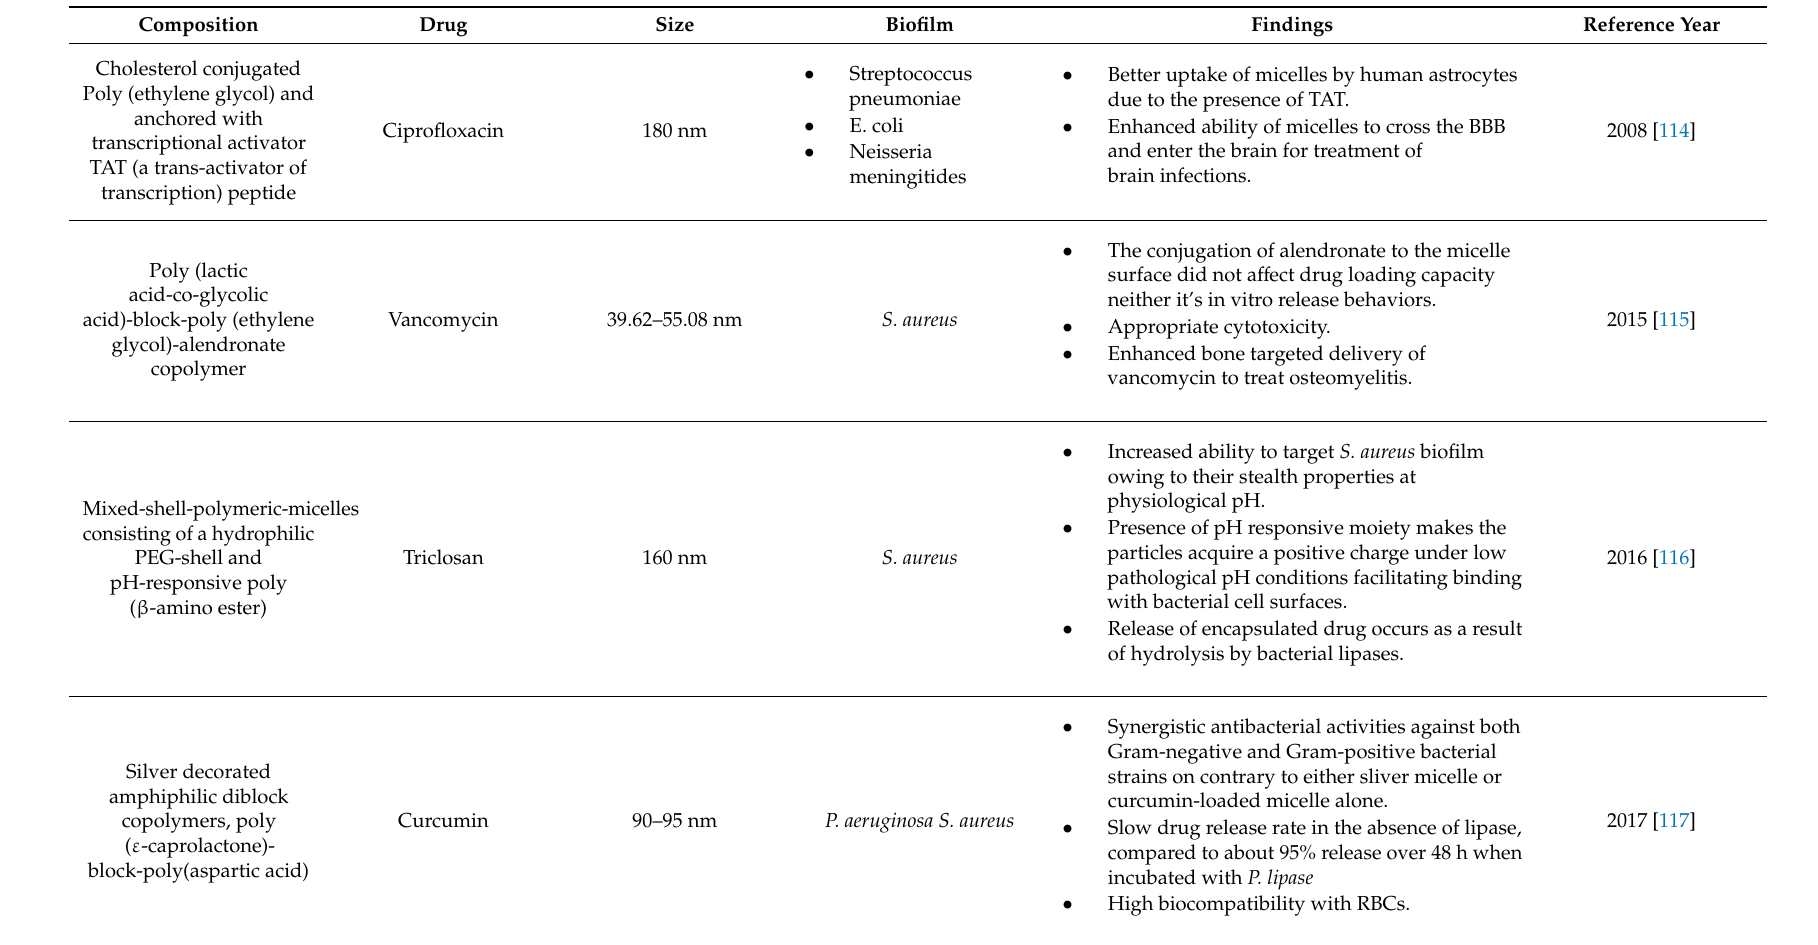
Table 3. Examples on recent studies on polymeric micelles against bacterial